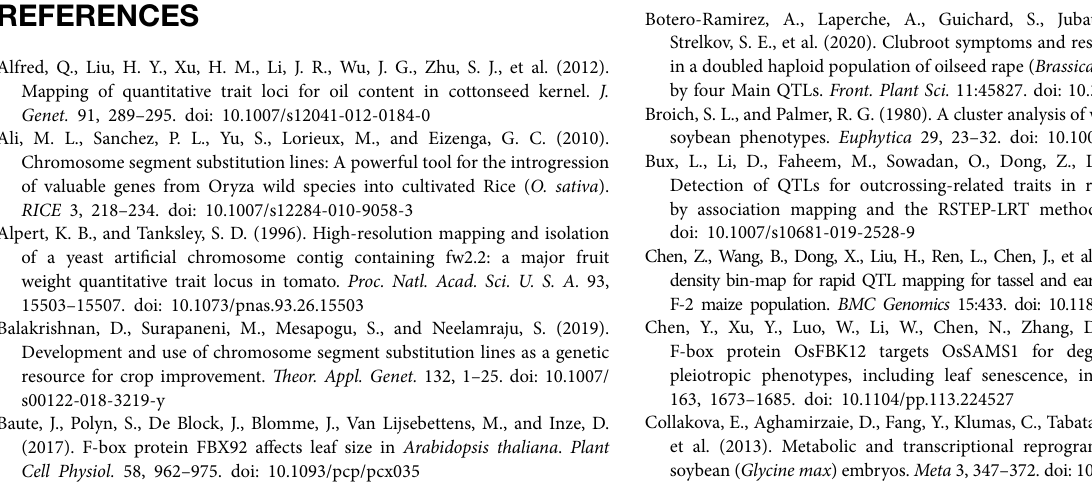
Supplementary Figure 1 | QTLs that mapped only in a single year. Supplementary Figure 2 | The fine mapping of qHSW12-3 . (A) Phenotypic of ZYD00006 and the parents of the secondary segregation. (B) The hundred-seed weight (HSW) of ZYD00006 and the parents of the secondary segregation. (C) The QTL mapping result of R183-F 2 . (D) The frequency chart of F 2:3 . (E) The QTL mapping result of R183-F 2:3 . (F) The frequency chart of RHL. (G) The QTL mapping result of RHL. Supplementary Figure 3 | Sequence comparison of promoter. Supplementary Figure 4 | Sequence comparison of transcript sequence. Supplementary Figure 5 | Sequence comparison of Protein